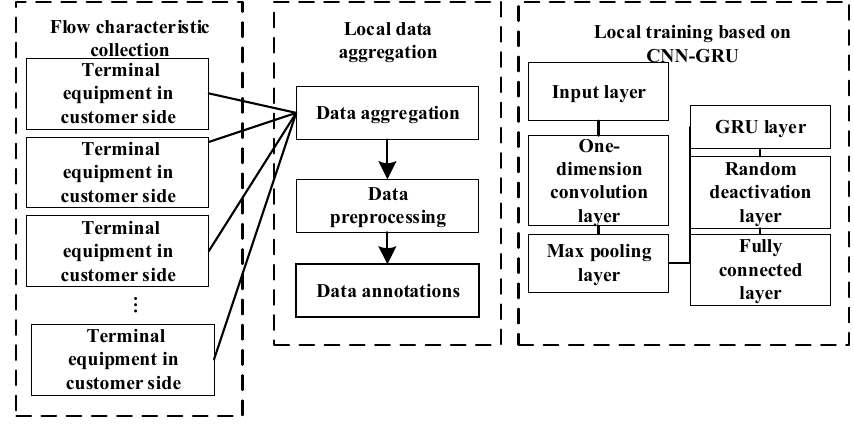
Figure 3. CNN–GRU multi-classification prediction model and its training process.